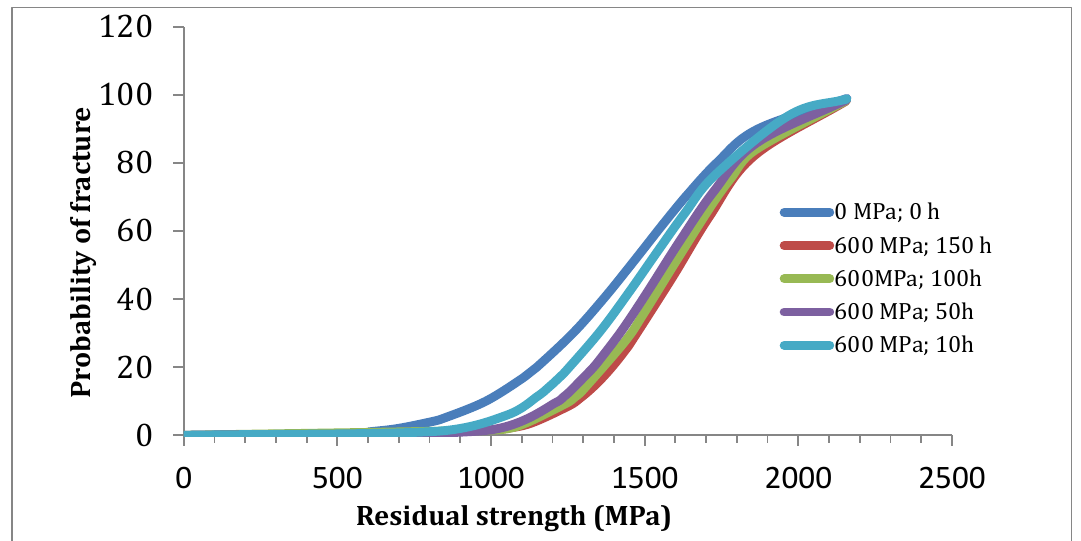
Figure 10. Prediction of the evolution of total distributions of residual strengths for various durations of static fatigue tests under the constant stress of 600 MPa.